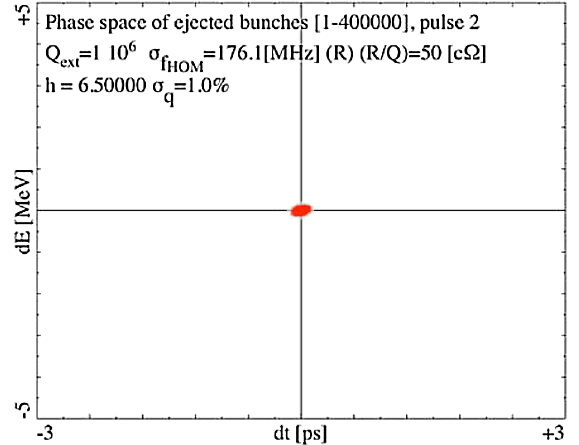
FIG. 36. (Color) Phase space at ejection for 250 independent HOMs (one per cavity) as Figs. 34 and 35 but Q ext ¼ 10 6 .